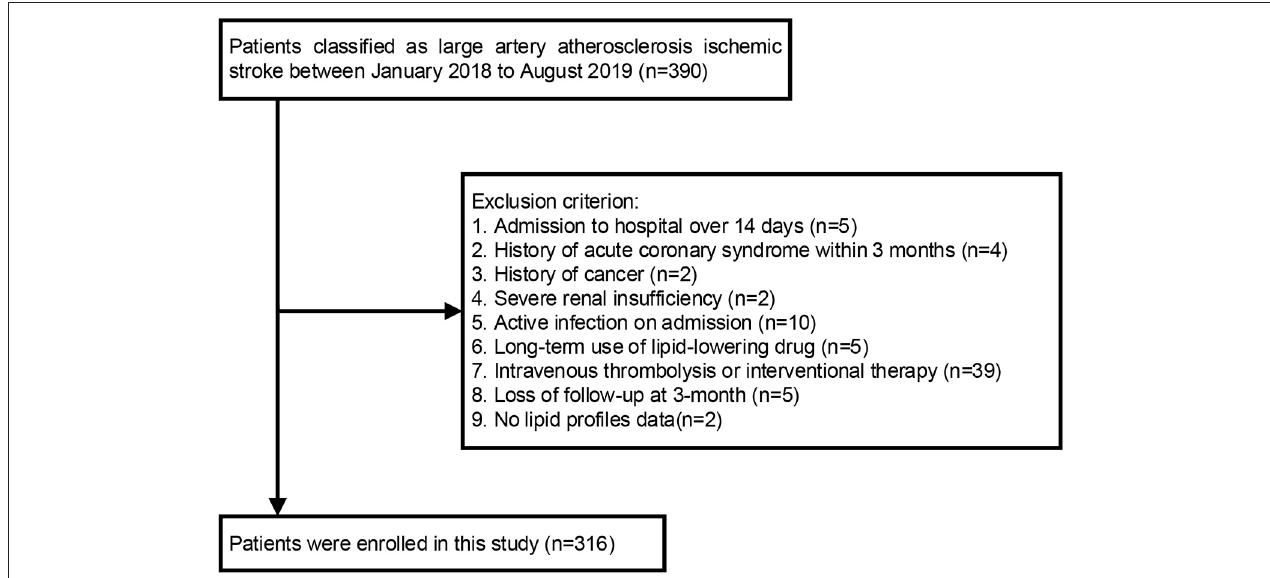
FIGURE 1 | Flowchart of participant